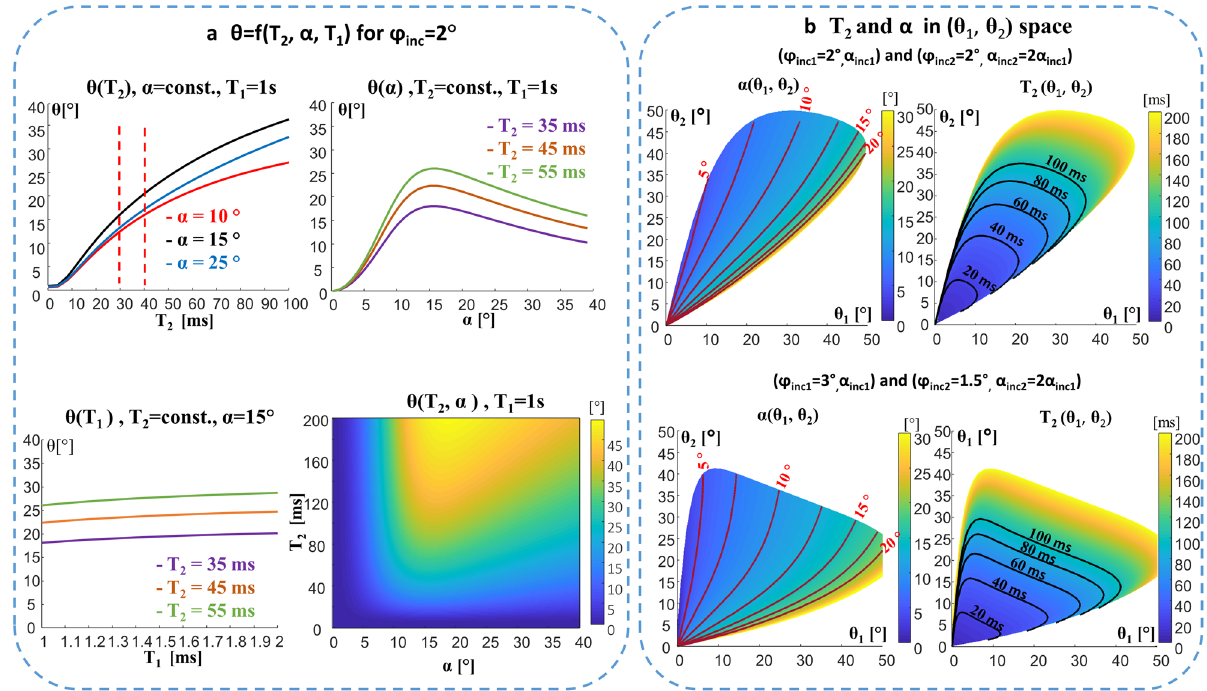
Figure 2. The phase of the steady-state signal as a function of T 2 and the flip angle. ( a ) θ(T 2 , α, T 1 ) dependence (Bloch simulation results) for a representative small φ inc (φ inc = 2°). The dependence on T 2 , α, and T 1 is shown in 1D plots and in 2D. ( b ) T 2 and α distributions in the new (θ 1 , θ 2 ) 2D space. Two examples are shown: Top— (φ inc1 = 2° , α scan1 ) with (φ inc2 = 2° , α scan2 = 2α scan1 ). Bottom—(φ inc1 = 3° , α scan1 ) with (φ inc2 = 1.5° , α scan2 = 2α scan1 ). In each case, α